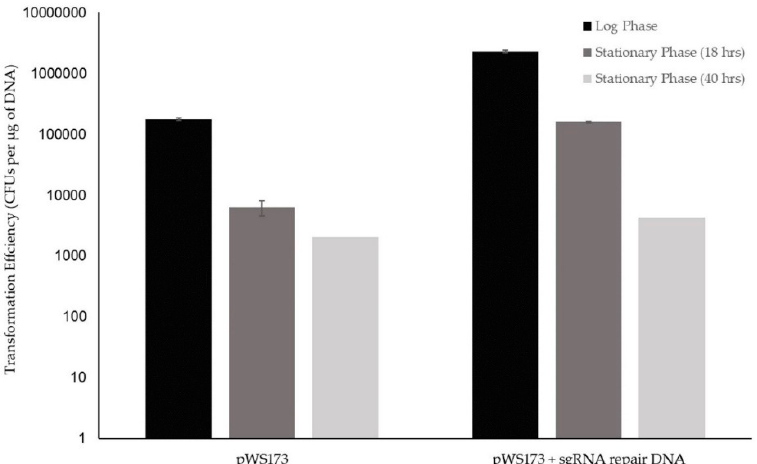
Figure 3. Log transformation e ffi ciency of log phase culture, 18-hour culture, and 40-hour culture, with 300 ng of pWS173 or 300 ng of linearized pWS173, with 1 µ g of non-functional sgRNA repair DNA. Single transformations were plated in triplicate on YPD with 200 µ g mL − 1 G418. Transformation e ffi ciency represents the average ± standard deviation.